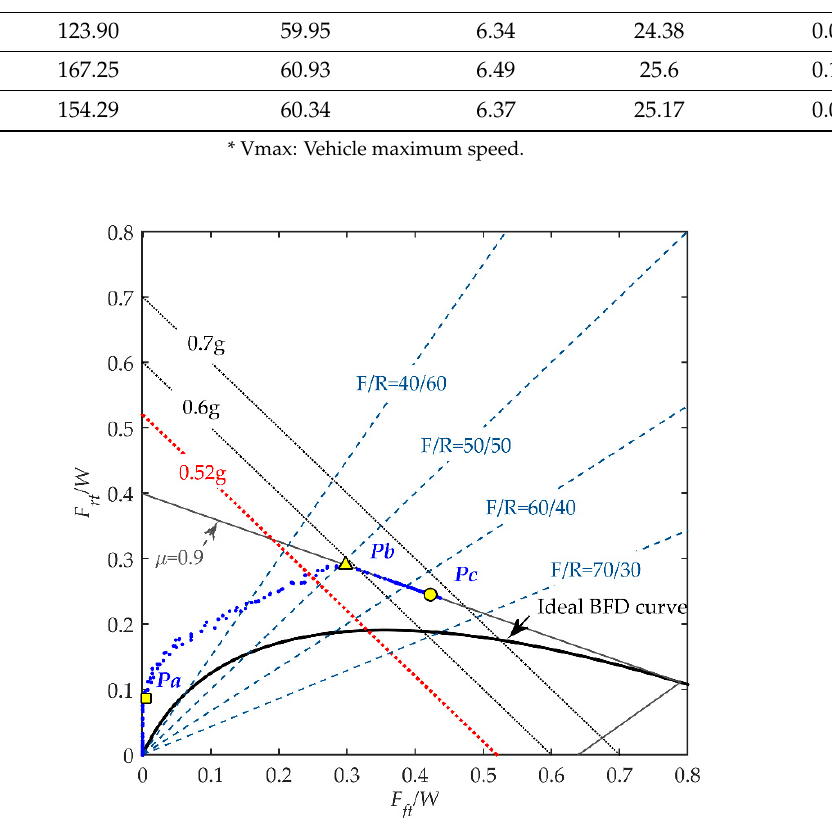
Figure 13. The BFD curves of the straight-line braking test.